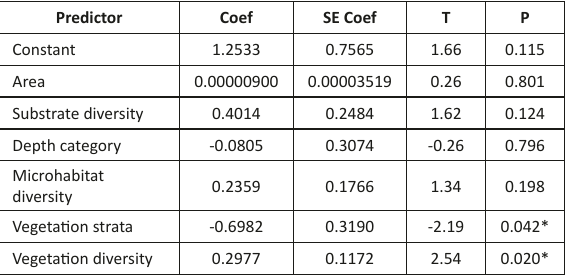
Table 3. Regression analysis of relationship between number of species and independent variables. Predictor Coef SE Coef